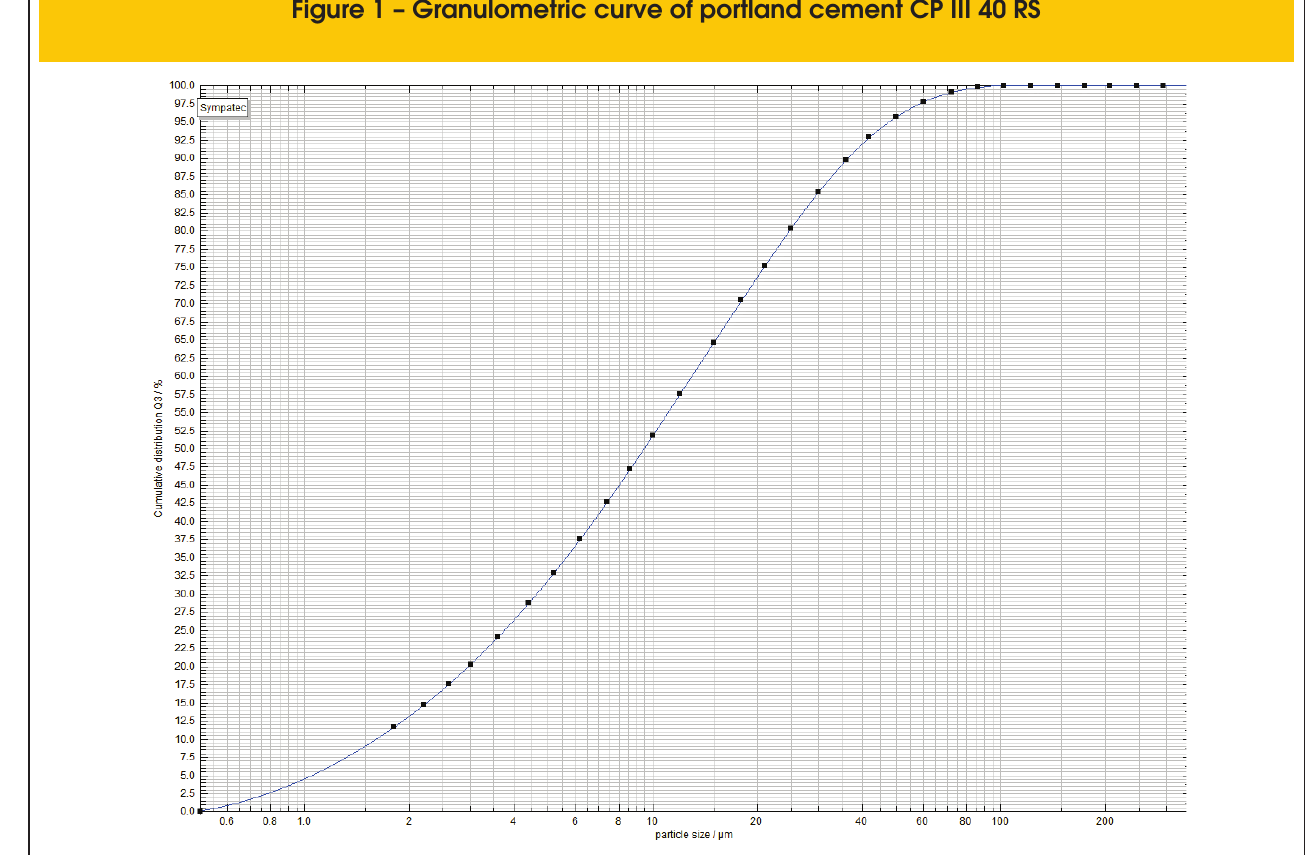
Figure 1 – Granulometric curve of portland cement CP III 40